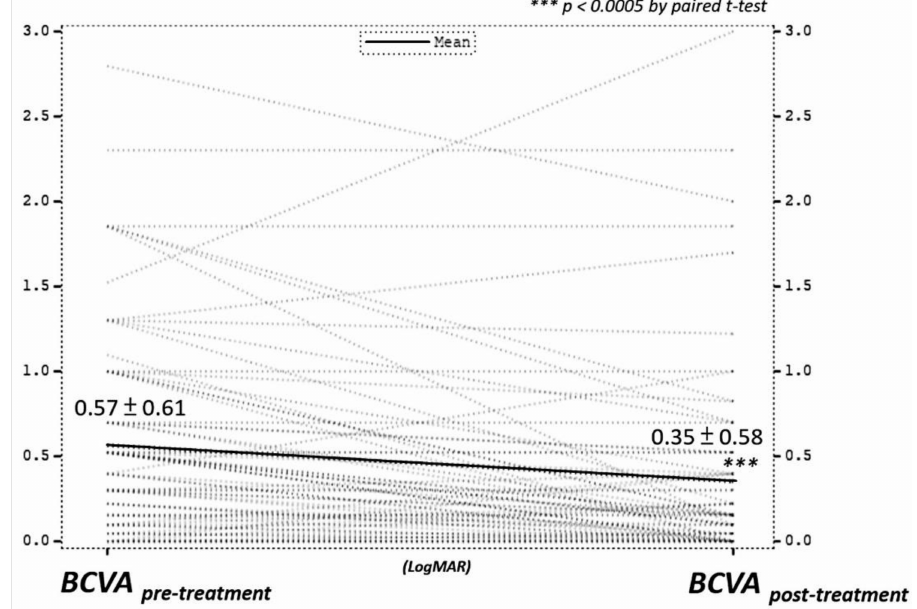
Figure 3. The significant BCVA improvement after treatment. *** p < 0.0005 by paired t -test. Table 3. In the final model of multiple regression, worse initial BCVA (ValmFirst), treatment of pyrazinamide (TxPyra), and receiving vitrectomy (TxVitr) predicted better BCVA improvement. Use of ethambutol (TxEtha) was associated with worse visual outcome after treatment. R 2 of final model: